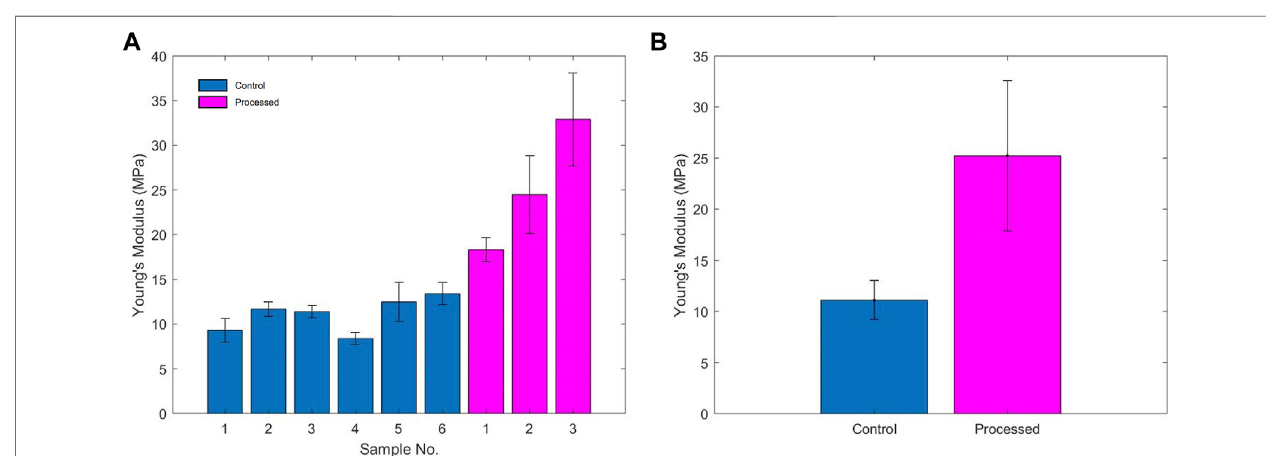
FIGURE 4 | (A) Young ’ s modulus of each of the samples; (B) average Young ’ s modulus of unprocessed and processed